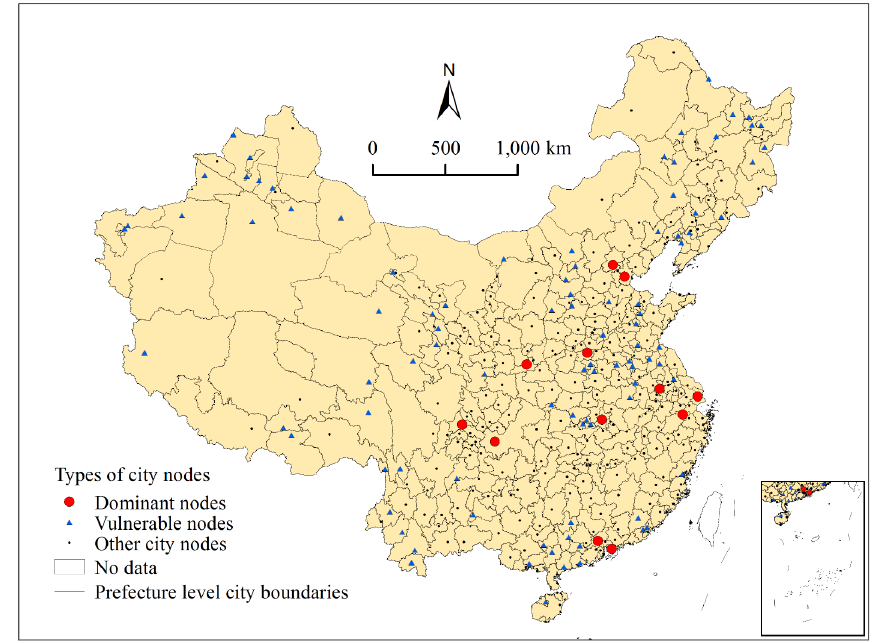
Figure 10. Spatial distribution of dominant and vulnerable nodes.